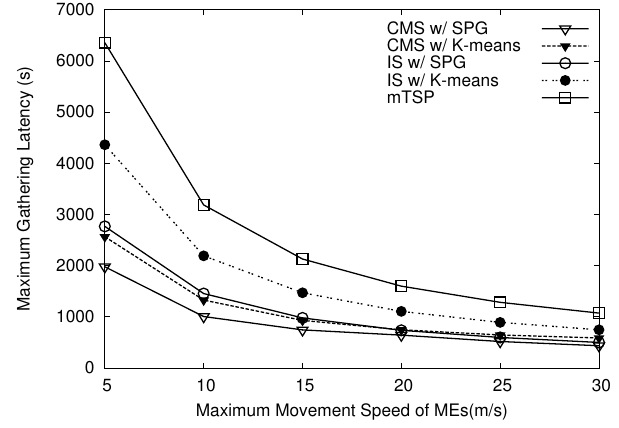
Figure 9. Effects of movement speed on maximum data-gathering